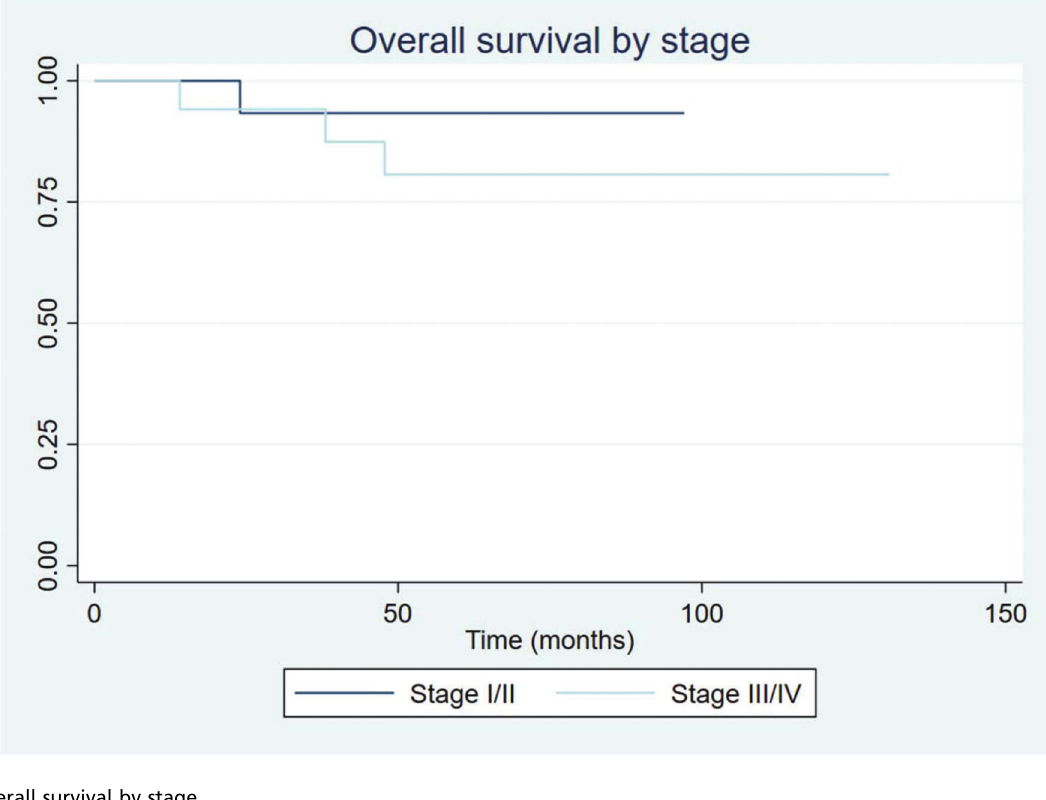
Fig 5 - Overall survival by stage.